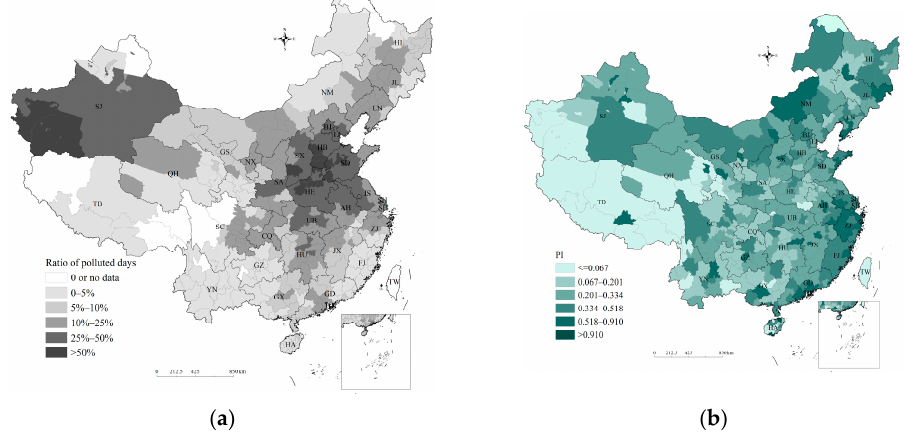
Figure 3. Air quality and PI in China: ( a ) proportion of polluted days; ( b ) PI. Table 3. Classification principles based on urban air quality and PI.